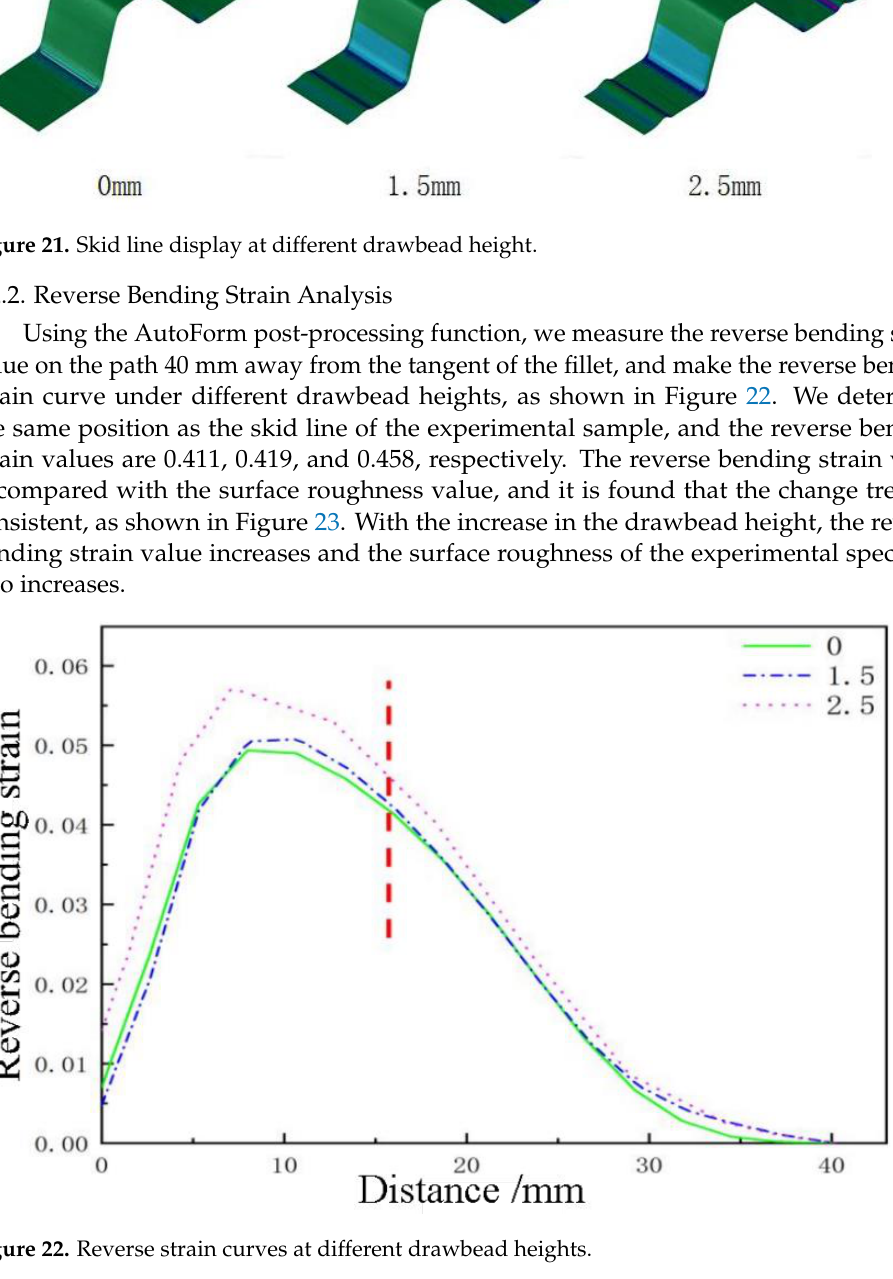
Figure 20. Contact pressure and surface roughness change curves at different drawbead height.